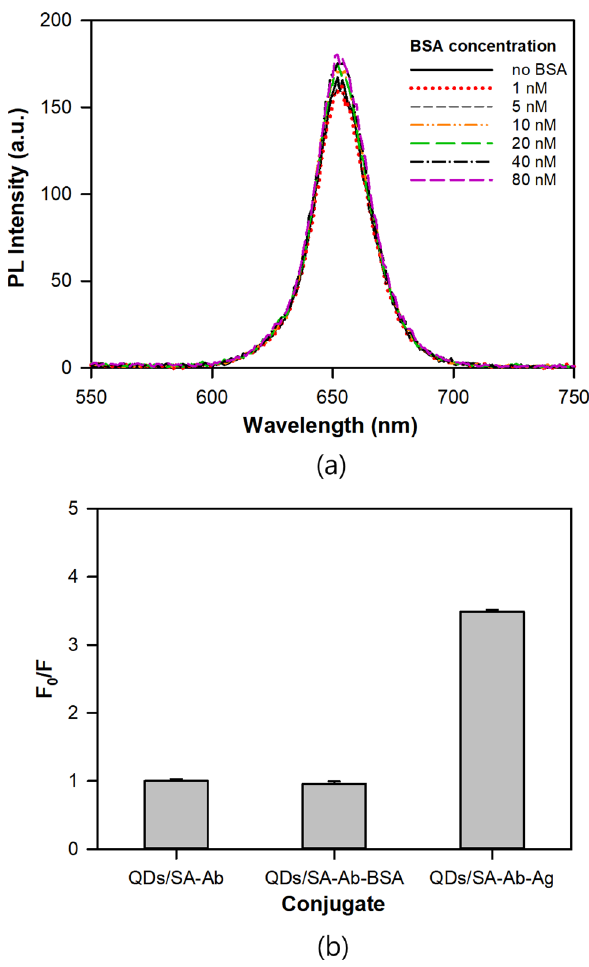
Figure 6. ( a ) PL emission spectra of QDs/SA-Ab upon conjugation with BSA, and ( b ) Comparison of F 0 /F values of QDs/SA-Ab-BSA and QDs/SA-Ab-Ag at concentration of 40 nM BSA or